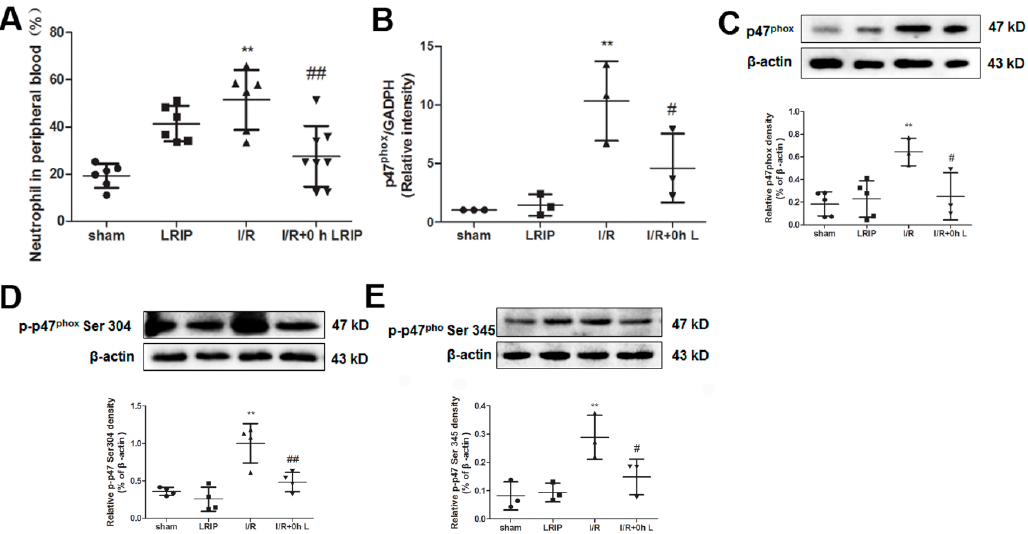
Figure 5. Effect of LRIP on the number of neutrophil and nicotinamide-adenine dinucleotide phosphate (NADPH) oxidase activation of peripheral blood: ( A ) Neutrophil count in the peripheral blood. Data are expressed as percentage of neutrophil in the peripheral blood ( n = 6); ( B ) qPCR result showing the mRNA expression change of p47 phox in the Sham, LRIP, I/R, and I/R + 0 h LRIP groups. Glyceraldehyde-3-phosphate dehydrogenase (GAPDH) is used as the internal control ( n = 3); ( C – E ) Western blot assessment of p47 phox and its phosphorylationat Ser 304 and Ser 345 in neutrophils from the peripheral blood were performed after 24 h reperfusion ( n = 3). Data are expressed as mean ± SD, ** p < 0.01 vs. sham group, # p < 0.05 vs. I/R group, ## p < 0.01 vs. I/R group.